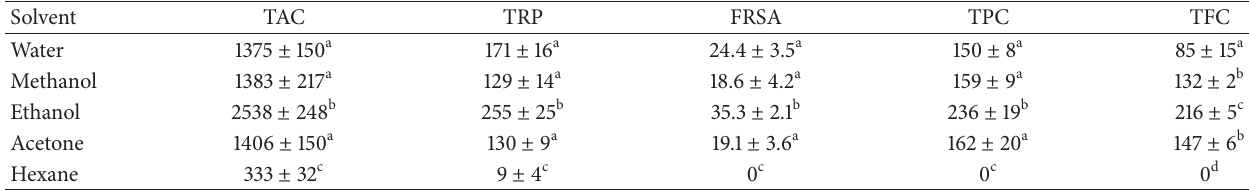
Ethanol Acetone Hexane 333 ± 32 c 9 ± 4 c 0 d In each column, values with different letters are statistically different ( P ≤ 0.05). TAC: total antioxidant activity ( 𝜇 g ISE mg −1 ), TRP: total reducing power ( 𝜇 gAAEmg −1 ), FRSA: free radical scavenging activity (% of DPPH inhibition), TPC: